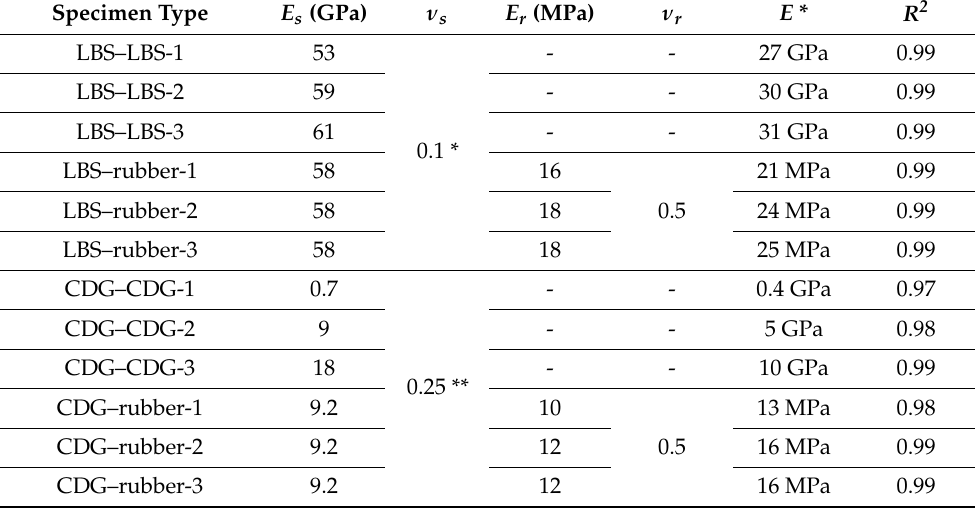
Figure 20. Hertz fitting for the first three cycles of normal loading tests for ( a ) sand–sand contact and ( b ) sand–rubber contact. Table 2. Fitting parameters using Hertz model for the first 3 cycles of loading for different interface types.